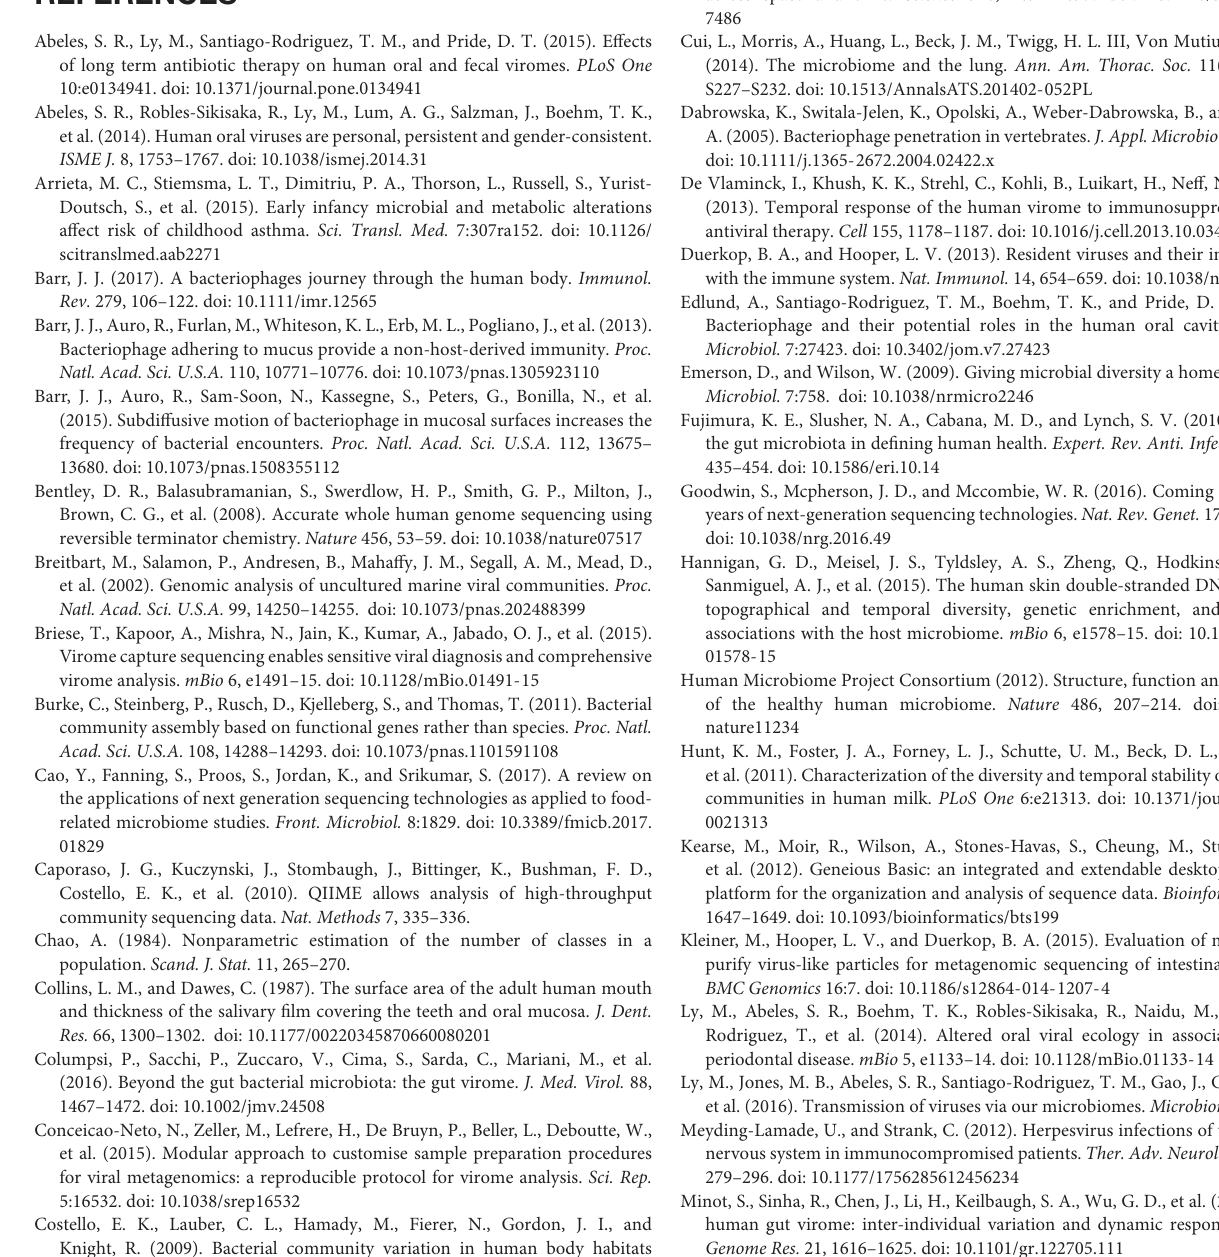
FIGURE S12 | Bar graphs representing the number of subjects that contributed to each assembled CSF contig (A) and the percentage of contigs constructed from the different numbers of subjects (B) . The x-axis represents the number of different subjects and the y-axis represents the number of contigs or the percentage of contigs constructed. FIGURE S13 | Homologous Virus Diversity Index rarefactions based on the Chao1 Index of viral communities from various specimen types. The x-axis represents the number of virome reads sampled, and the y-axis represents homologous diversity. The CSF specimens sequenced using semiconductor sequencing (yellow circles) had higher diversity than those sequenced by Illumina (white circles), but remained in the low diversity cluster.